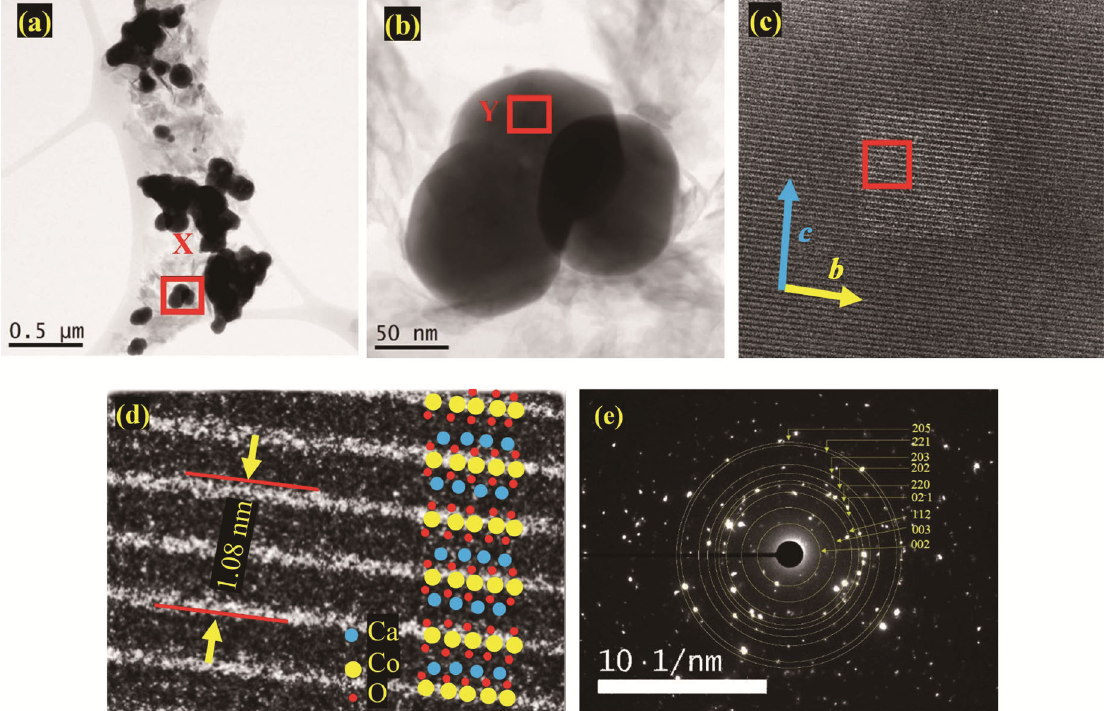
Fig. 9 TEM image of Ca 3 Co 4 O 9 structure with (a) low-magnification image, (b) enlargement of X-area, (c) enlargement of Y-area, (d) lattice-resolved TEM image and schematic of the atomic arrangement of the layers. (e) shows the SAED patterns recorded from the respective